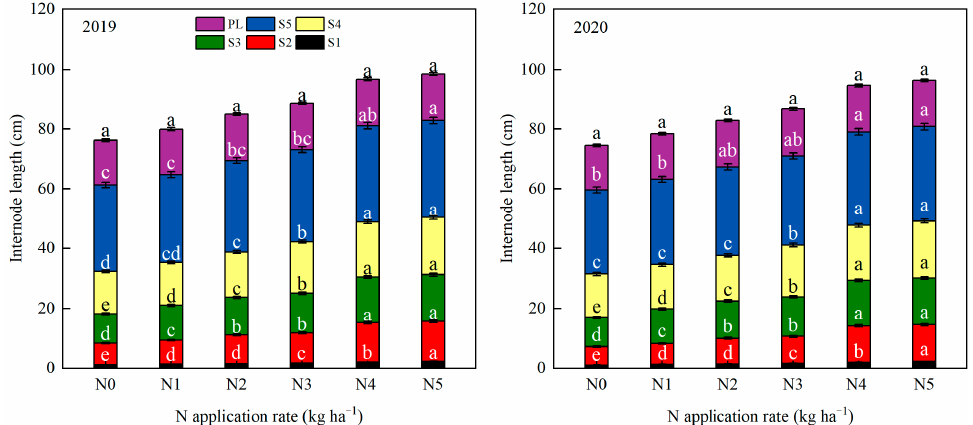
7 of 16 Figure 3. Relationship between SL, FW and WP of rice under dry cultivation under different N ap- plication rate in 2019 and 2020. N0, N1, N2, N3, N4 and N5 refer to the N application rate being 0, 70, 140, 210, 280 and 350 kg ha − 1 , respectively. WP: Bending moment of the whole plant. SL: The distance from the broken point to the panicle top. FW: The fresh weight from the broken point to the panicle top. 3.2. Effect of N application on Morphological Traits of Main Stems of Rice Under Dry Cultiva- tion The internode lengths under different treatments of N application are shown in Fig- ure 4. The basal internode length (S1+S2), upper internode length (S3+S4+S5), and spike length of rice under dry cultivation tended to increase in both years as the amount of fertilizer applied increased. Compared with the N0 treatment, the basal internode length, upper internode length and spike length of rice under dry cultivation increased by 17.72– 55.82%, 7.34–34.21% and 1.60–5.01%, respectively, under the N1–N5 treatments. The in-